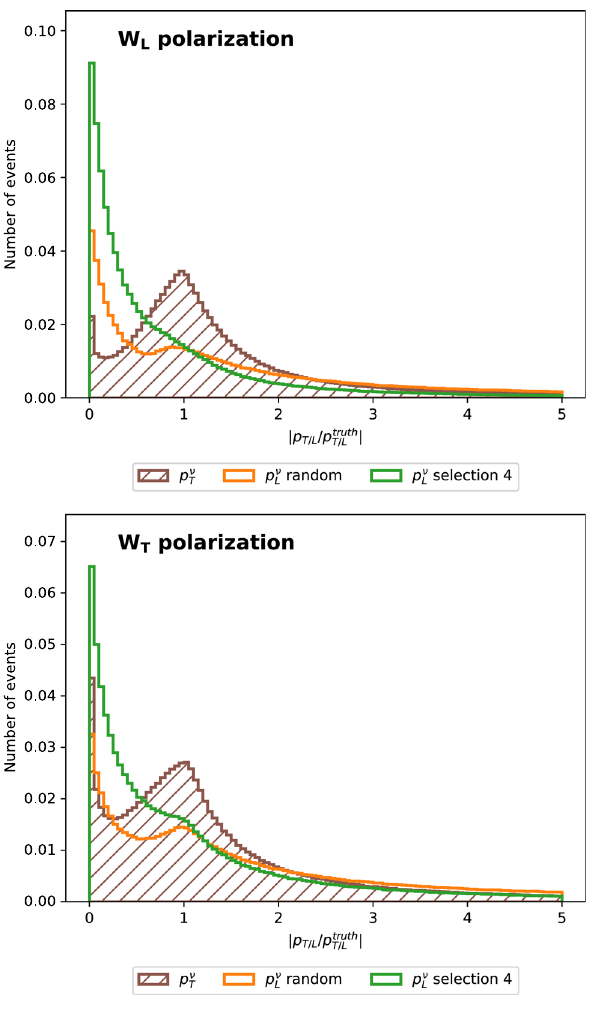
Fig. 5 Reconstruction of the neutrino momenta in the fully-leptonic channel at the truth (generator) level using the MAOS approach. The ratio between the reconstructed and true neutrino momentum is shown for the longitudinal and transverse components. The top plot shows results obtained assuming the purely longitudinal (W L ) and the bottom plot the purely transverse (W T ) scenario. While the transverse momenta are reconstructed using the MAOS procedure, the W mass constraint from the semi-leptonic case is adopted for reconstruction of both lon- gitudinal neutrino momenta. The random choice and selection 4, as described in Sect. 4.2, were studied as strategies to resolve solution ambiguities